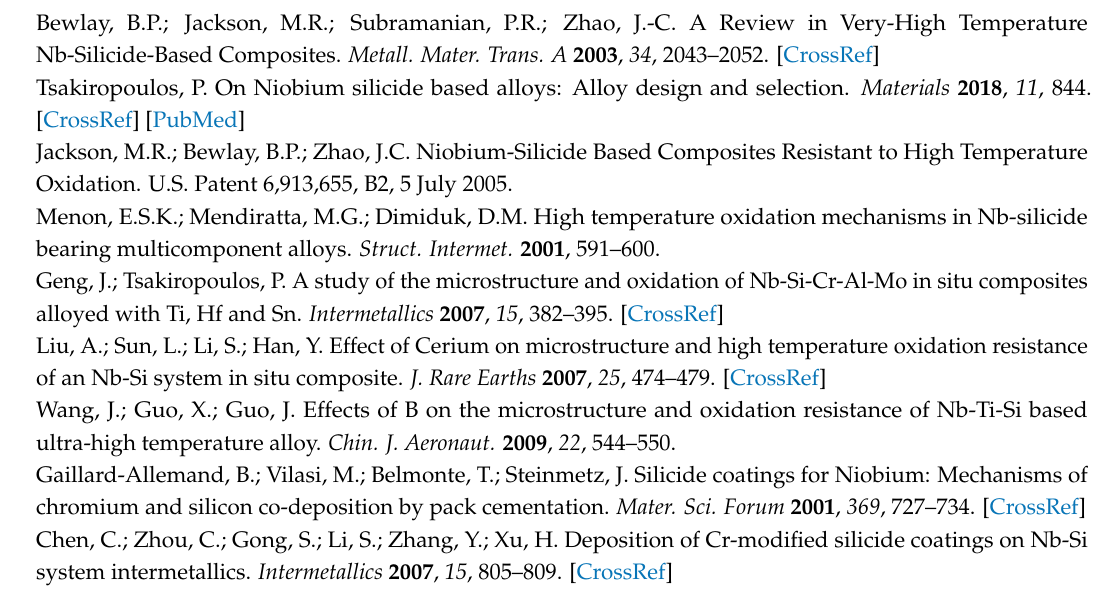
s1, Table S1: EPMA analysis data (at.%) for phases in the alloy NbSiTiHf-5Al-5Cr after isothermal oxidation at 800 ◦ C, Table S2: EPMA analysis data (at.%) for phases in the alloy NbSiTiHf-5Al-5Cr after isothermal oxidation at 1200 ◦ C, Table S3: Comparison of the isothermal oxidation of the alloys NbSiTiHf-5Al and NbSiTiHf-5Al-5Cr with other Nb silicide based alloys, Figure S1: X-ray diffractograms of the (a) as cast and (b) heat treated alloy NbSiTiHf-5Al and (c) cast and (d) heat treated alloy NbSiTiHf-5Al-5Cr. The non-indexed peaks correspond to un-identified phase(s), Figure S2: Specimens of the alloys NbSiTiHf-5Al (a) and NbSiTiHf-5Al-5Cr (b) after 100 h isothermal oxidation at 800 ◦ C, Figure S3: Specimens of the alloys NbSiTiHf-5Al (a) and NbSiTiHf-5Al-5Cr (b) after 100 h isothermal oxidation at 1200 ◦ C, Figure S4: Isothermal oxidation data for the alloy NbSiTiHf-5Al (a) 800 ◦ C, (b) 1200 ◦ C, Figure S5: Isothermal oxidation data for the alloy NbSiTiHf-5Al-5Cr (a) 800 ◦ C, (b) 1200 ◦ C, Figure S6: BSE images of cross sections of the alloy NbSiTiHf-5Al after isothermal oxidation (a) at 800 ◦ C and (b) at 1200 ◦ C, Figure S7: XRD data for the alloy NbSiTiHf-5Al (a) glancing angle data (GXRD, θ = 5 degrees) for 800 ◦ C, (b) powder XRD data from the spalled off scale at 1200 ◦